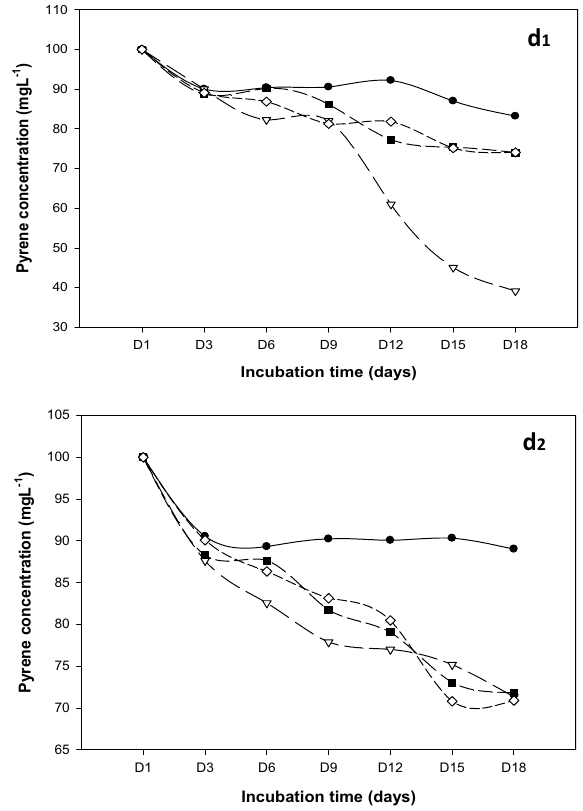
Figure 10. Pyrene degradation curves at ( d1 ) pH 5.0 and ( d2 ) pH 9.0; Control experiments (solid sphere), B. brevis (solid squares), P. mirabilis (diamond), and R. qinshengi (triangle).